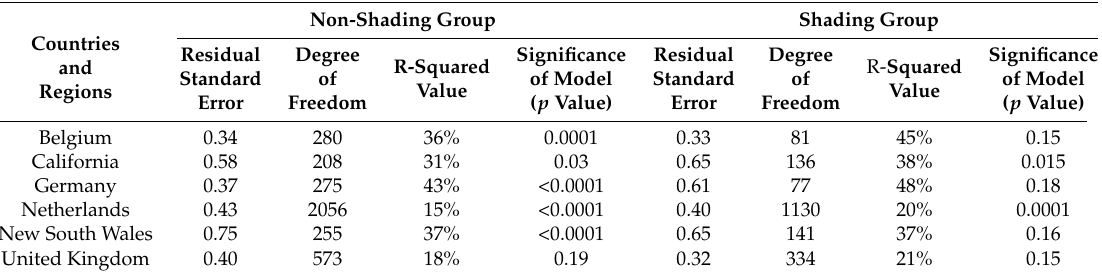
Table 3. The results of the multiple linear regression analysis of panel and inverter configurations.